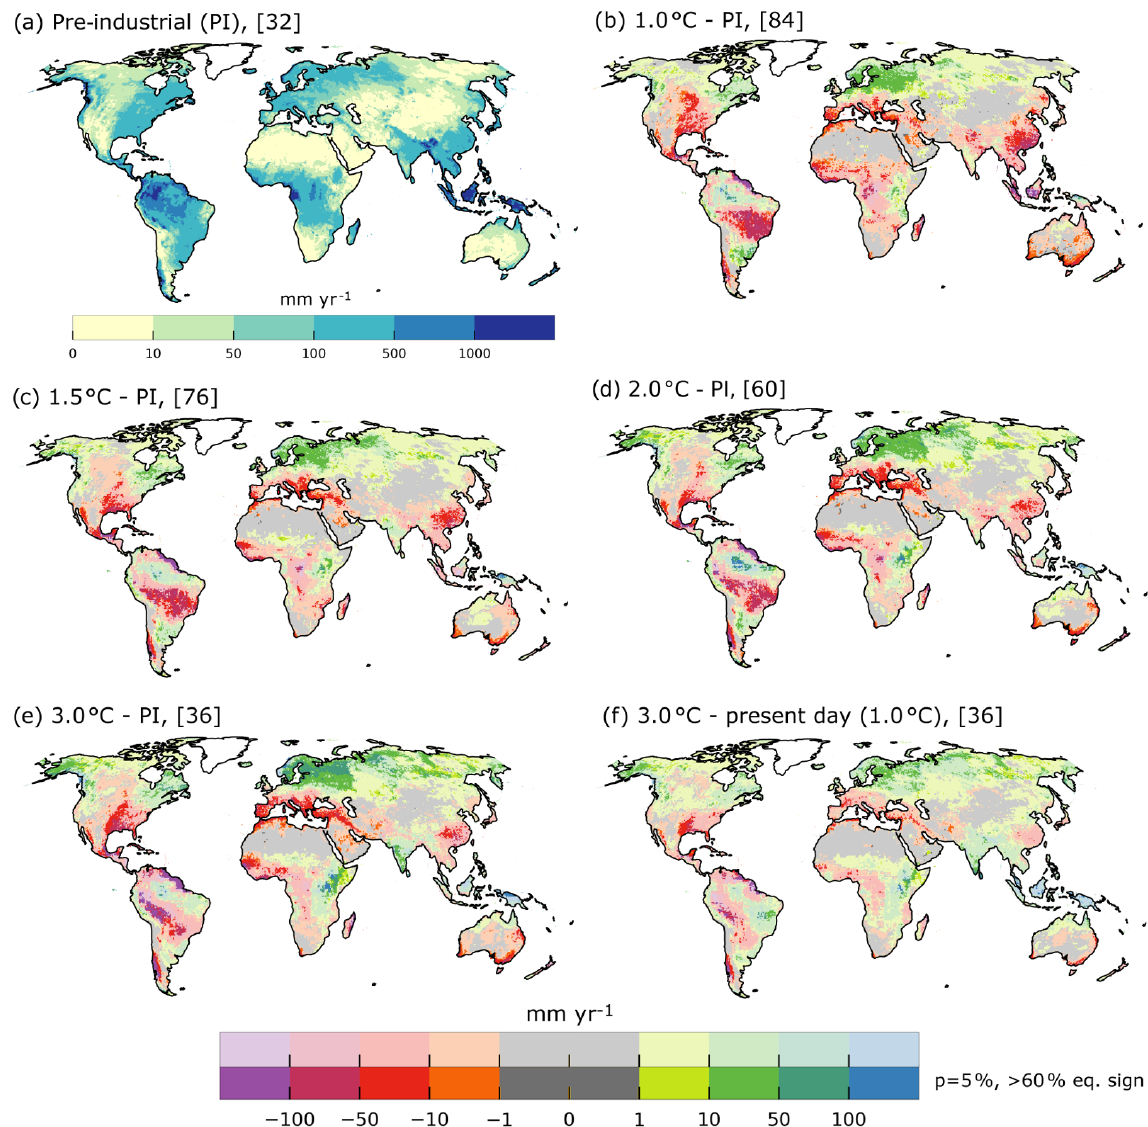
Figure 3. Mean GWR (mmyr − 1 ) for pre-industrial greenhouse gas concentrations, averaged over the GWR of all GHMs and GCMs (a) . Ensemble mean absolute change in GWR (mmyr − 1 ) at 1.0 ◦ C (b) , 1.5 ◦ C (c) , 2.0 ◦ C (d) , and 3.0 ◦ C (e) GW compared to PI. The ensemble mean absolute change in GWR (mmyr − 1 ) for 3.0 ◦ C GW compared to GWR at the current GW of 1 ◦ C (f) . For (b) to (f) , only those cells are displayed in solid colors where the Kolmogorov–Smirnov (K–S) test with a p of 5% indicated that the ensemble GWR distribution for PI (for (f) the GWR distribution at 1 ◦ C) and for the GW level difference, and at least 60% of the models agree on the sign of the change. The ensemble size is shown in brackets. Lighter colors (upper color bar) show (statistical) insignificant mean